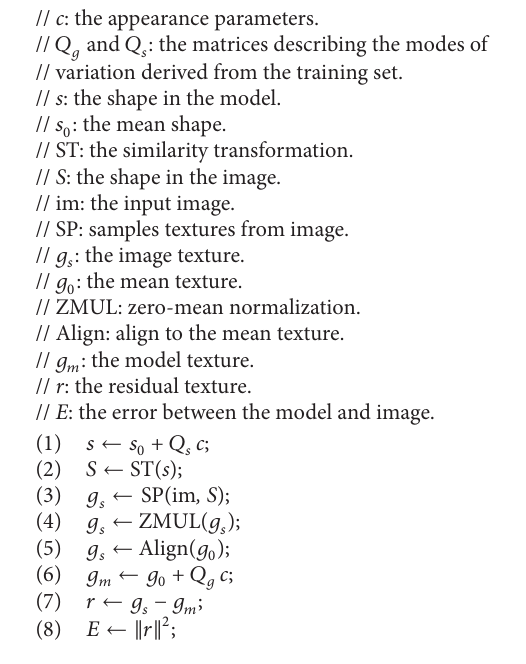
Algorithm 2: CPU-based method for computing 𝐸 .